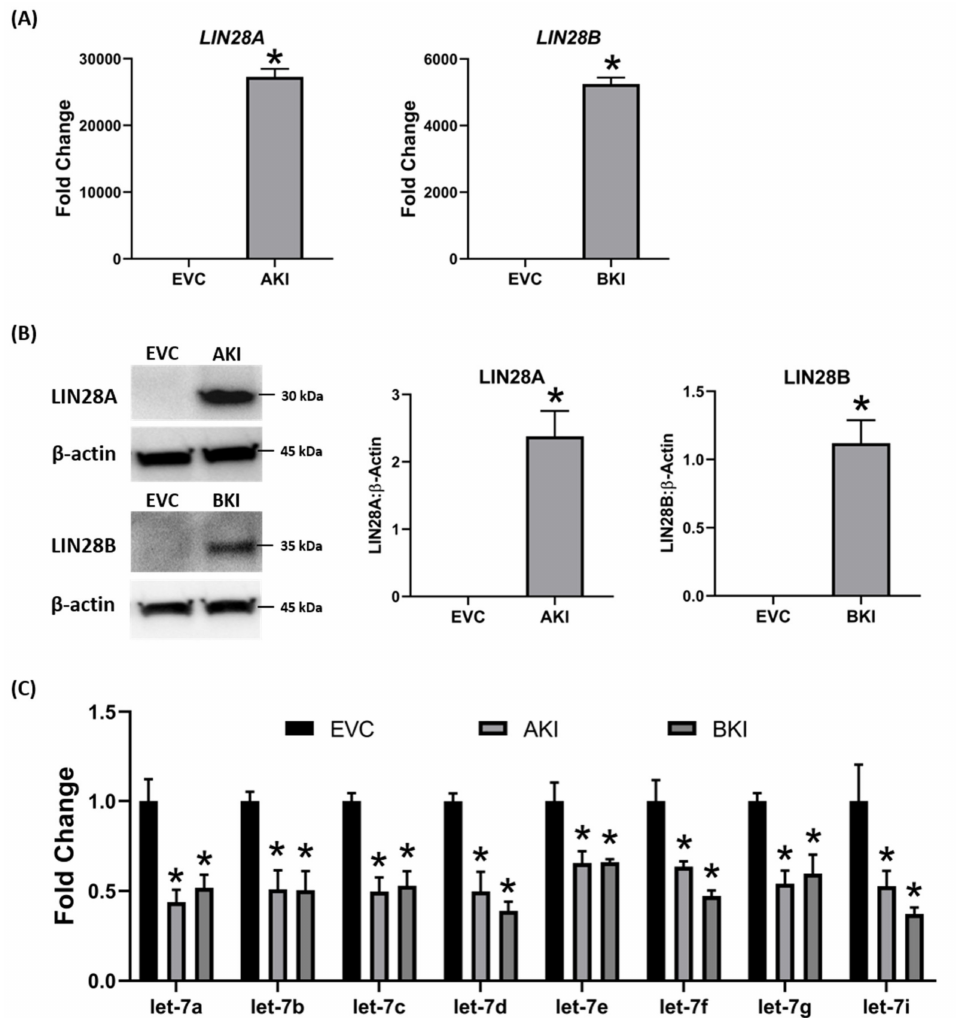
Figure 8. LIN28A, LIN28B, and let-7 miRNAs in LIN28A knockin (AKI) and LIN28B knockin (BKI) immortalized ovine trophoblast (iOTR) cells. ( A ) LIN28A and LIN28B mRNA in AKI and BKI iOTR cells compared to expression vector control (EVC). ( B ) Representative immunoblots for LIN28A, LIN28B, and β -actin, and densitometric analysis of immunoblotting results in AKI and BKI iOTR cells compared to EVC. ( C ) Let-7 miRNAs in AKI and BKI iOTR cells compared to EVC ( n = 3), * p < 0.05 vs.